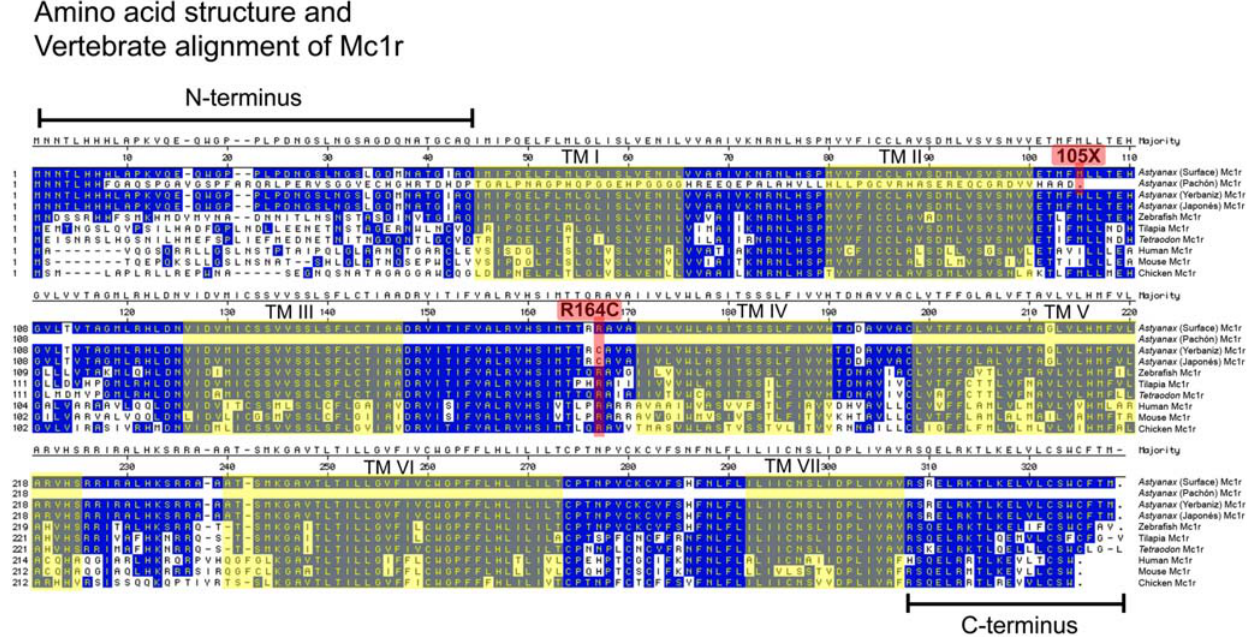
Figure 6. Vertebrate alignment of the amino acid sequence of Mc1r. Mc1r protein sequences of Surface (wild type) and three populations of cave Astyanax , three teleost fish species (zebrafish, Tilapia, Tetraodon), and three amniotes (human, mouse, chicken) were aligned using MegAlign 6.1. Conserved protein sequences are depicted in blue, unconserved regions are shown in white. The seven (I–VII) transmembrane domains (TM) are shaded in yellow. The positions of the premature stop codon introduced at position 105 in the Pacho´n form of Mc1r, and the arginine mutation at position 164 found in individuals derived from the Yerbaniz and Japone´s caves are depicted in red. Transmembrane domains are predicted from [66].